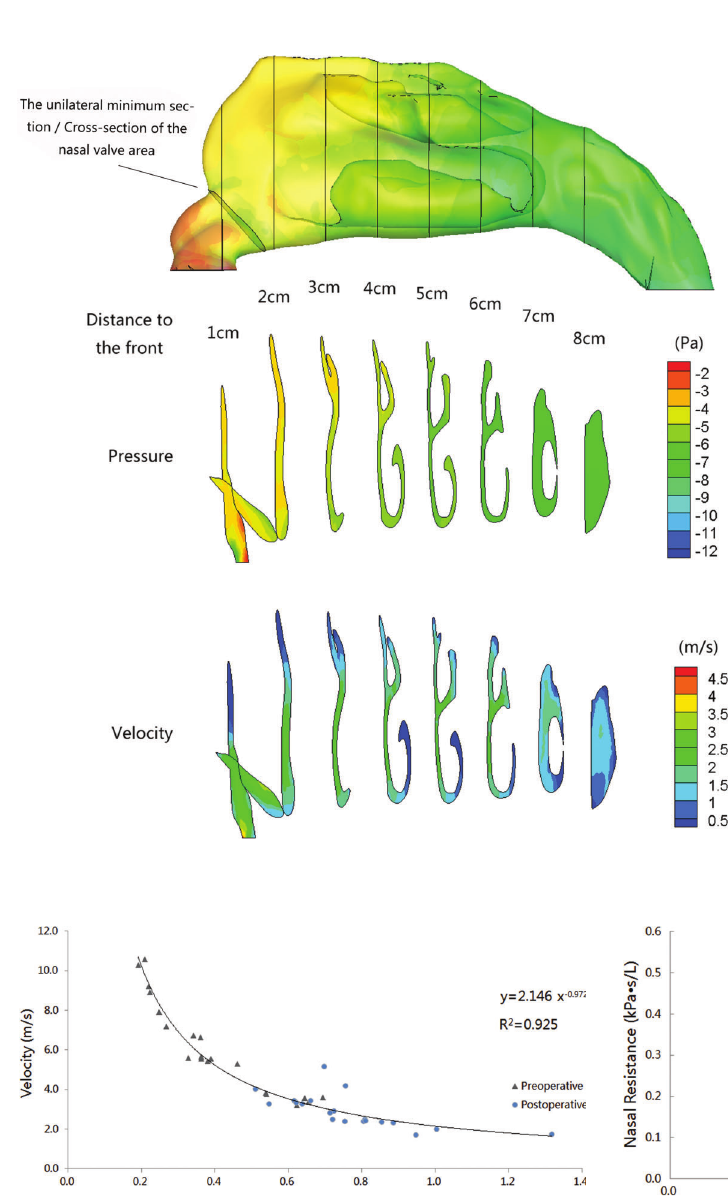
Figure 5. Representative lateral view cross-section showing the pressure and velocity gradient distribu- tion from nostril to nasopharynx.